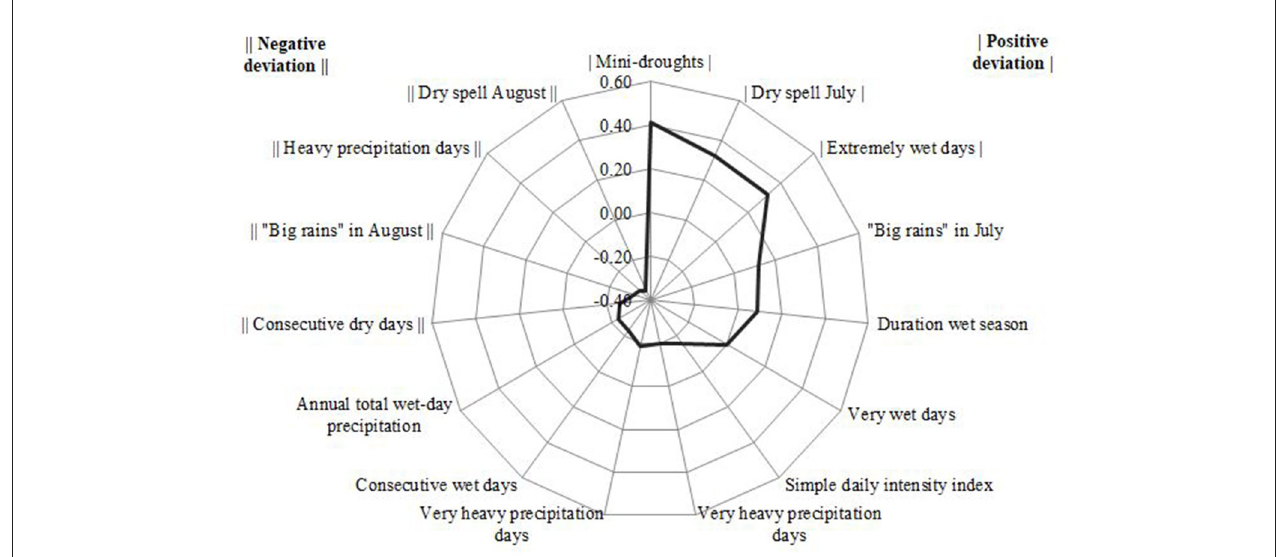
TABLE 3 | Multilevel regression models (child-household-village) examining the factors of the PVS on HAZ and WHZ of young children in the Nouna HDSS area. Adherence to the PVS Ref. tertile Second tertile Third tertile Per 1-point increase of the Low Medium High PVS HAZ ( N = 1,364) ß-coef. ß-coef. 95% CI ß-coef. 95% CI ß-coef. 95% CI Unadj. model 0.00 − 0.008 − 0.02, 0.01 − 0.012 − 0.03, − 0.01 − 0.029* − 0.06, − 0.00 − 0.028 − 0.06, 0.00 WHZ ( N = 1,359) ß-coef. ß-coef. 95% CI ß-coef. 95% CI ß-coef. 95% CI 0.013 − 0.01, 0.04 0.032* 0.01,